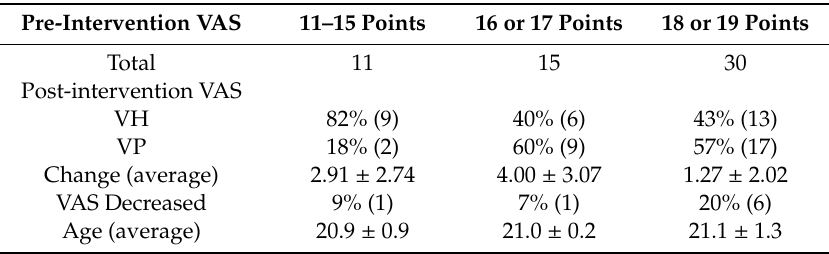
Table 4. Numerical breakdown of all VH students by pre-intervention